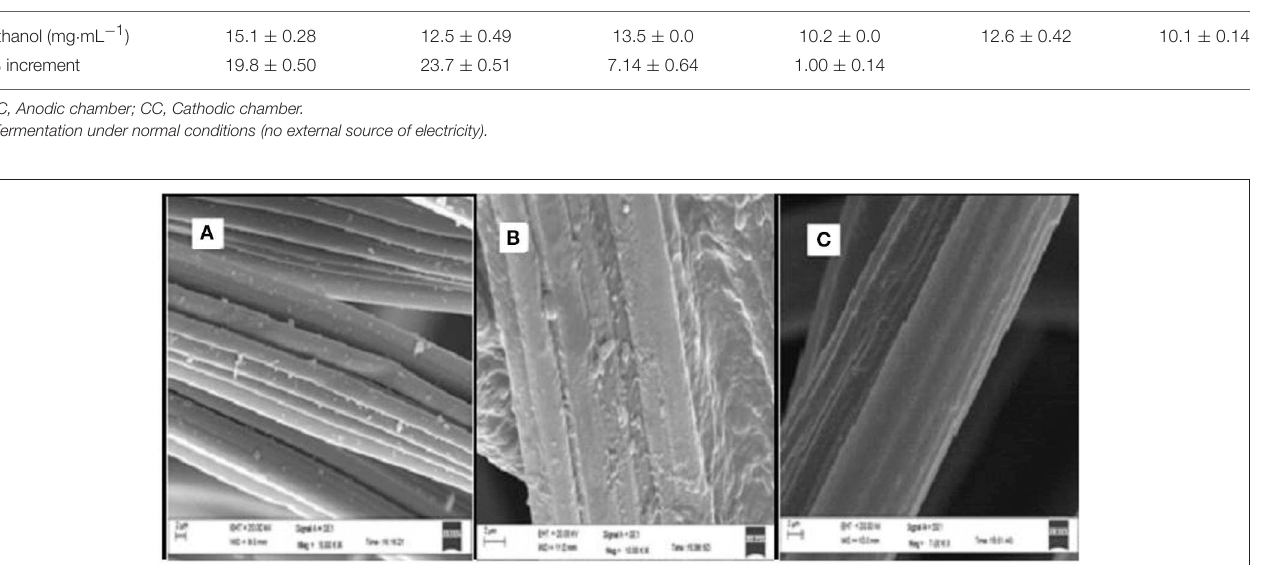
compartment. Once again, CDBT2 produced the highest amount of ethanol ( Figure 4A ) as compared to other S. cerevisiae